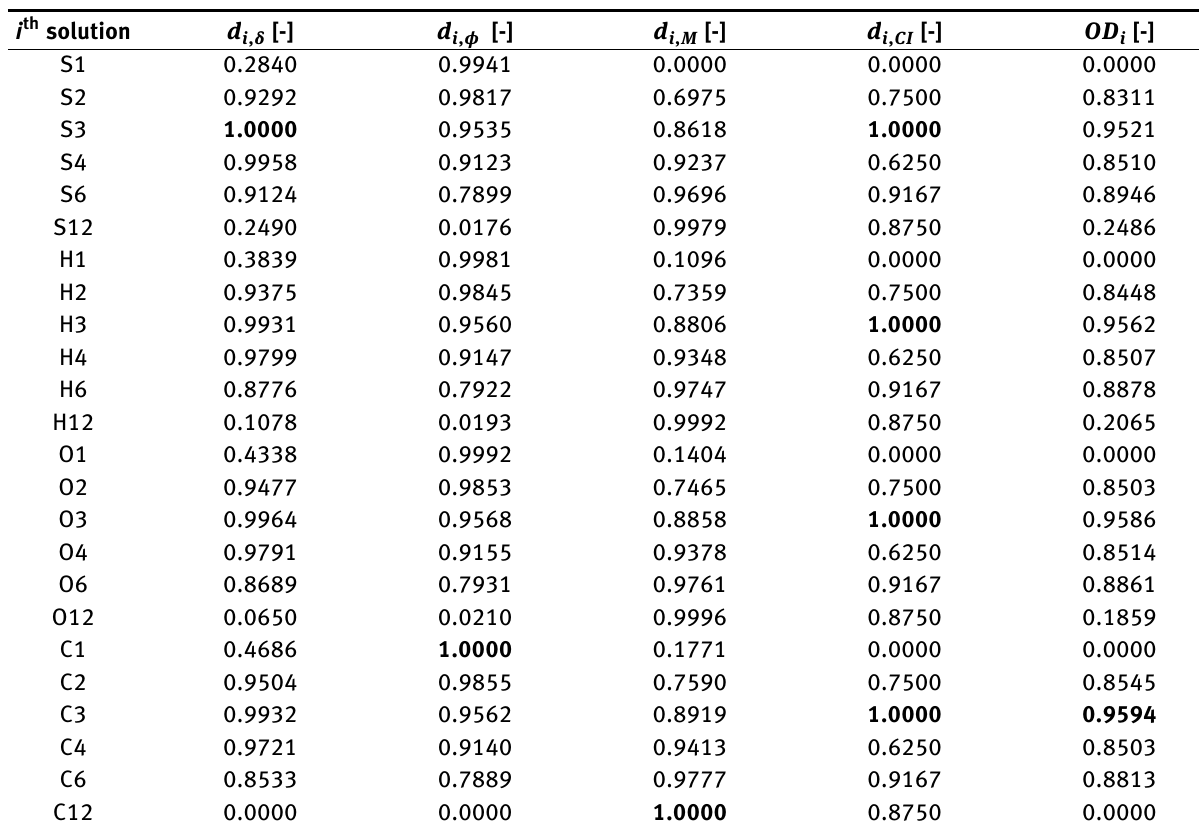
Table 3: Individual and overall desirability values for the four response variables ( r p = 1 ) i th